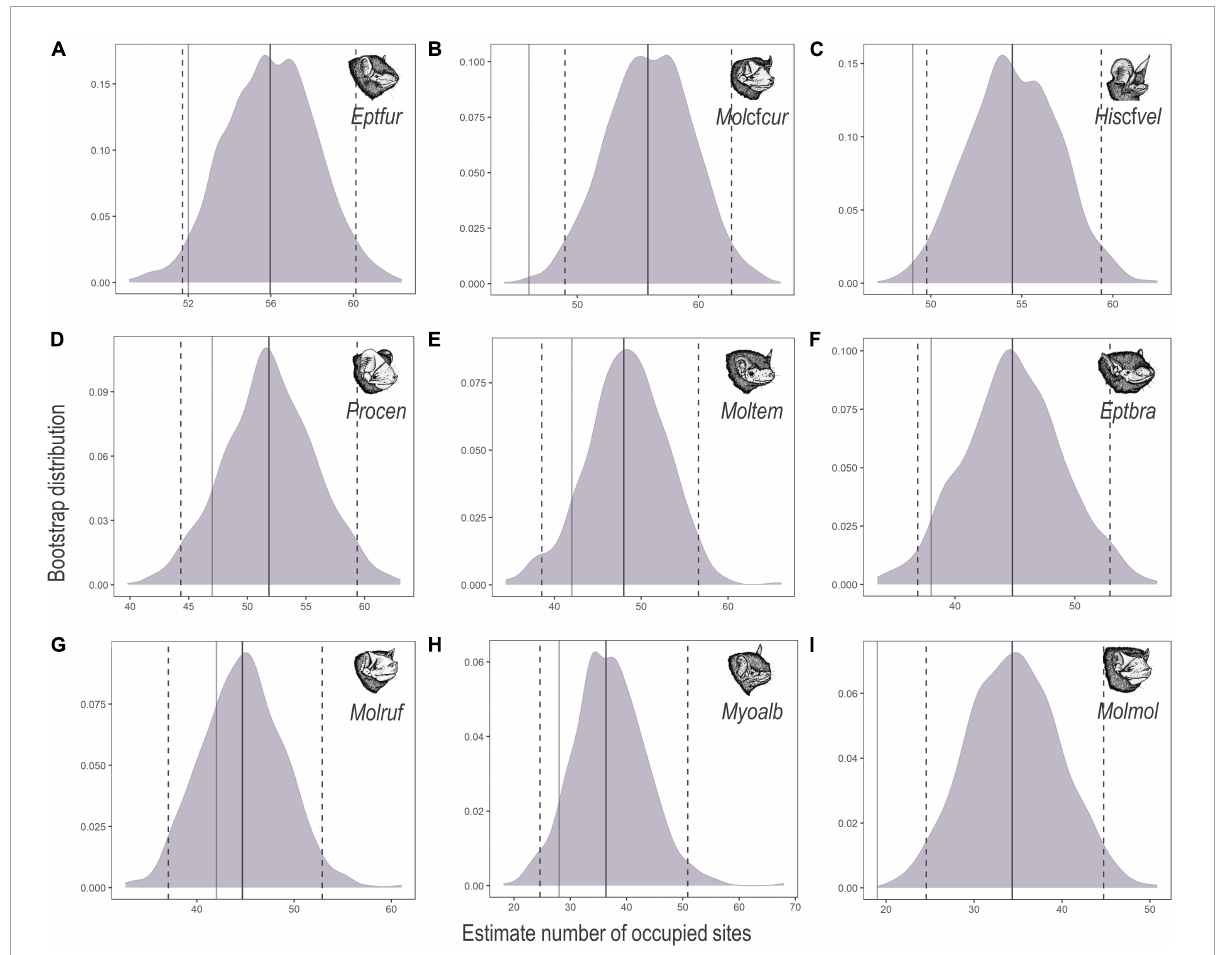
FIGURE2 Bootstrap distributions of the estimated number of sites occupied ( ψ FS) by (A) Eptesicus furinalis ( Eptfur ), (B) Molossus cf. currentium ( Mol cf cur ), (C) Histiotus cf. velatus ( His cf vel ), (D) Promops centralis ( Procen ), (E) Molossops temminckii ( Moltem ), (F) Eptesicus brasiliensis ( Eptbra ), (G) Molossus rufus ( Molruf ), (H) Myotis albescens ( Myoalb ), and (I) Molossus molossus ( Molmol ) across 68 acoustic survey sites in the Brazilian Pampa during spring and summer 2019 and 2020. Mean occupancy estimates (solid purple lines) and 95% confidence intervals (dashed purple lines) are shown, along with the total number of survey sites at which each species was detected (solid grey lines). Panels are in order of decreasing probability of